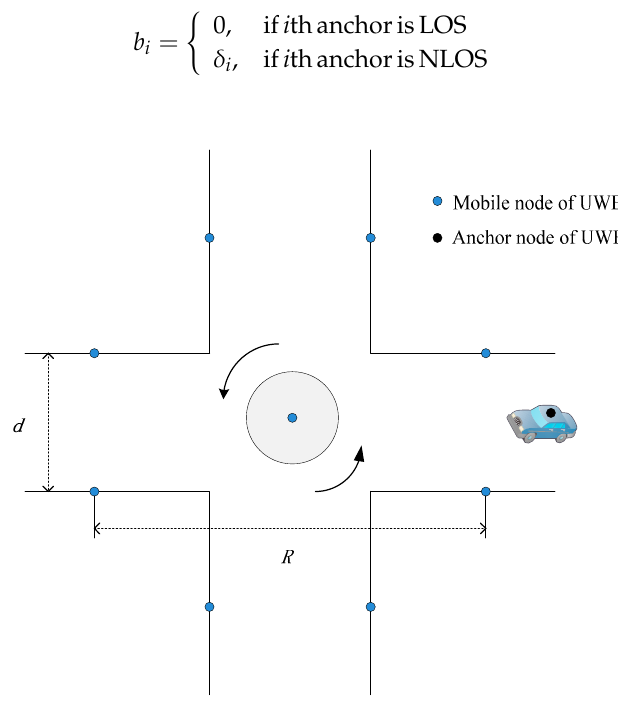
Figure 2. Illustration of UWB deployment at typical roundabout intersection. Sensors 2019 , 19 ,